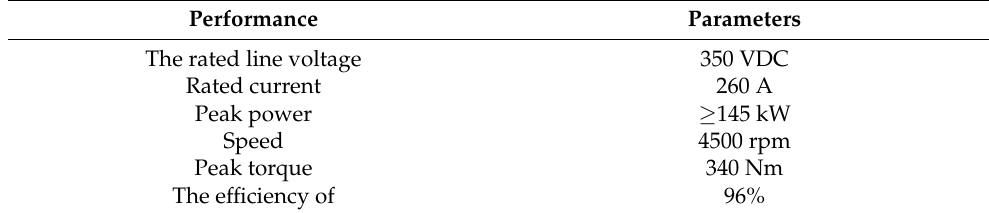
Table 1. Electrical machine performance parameters.